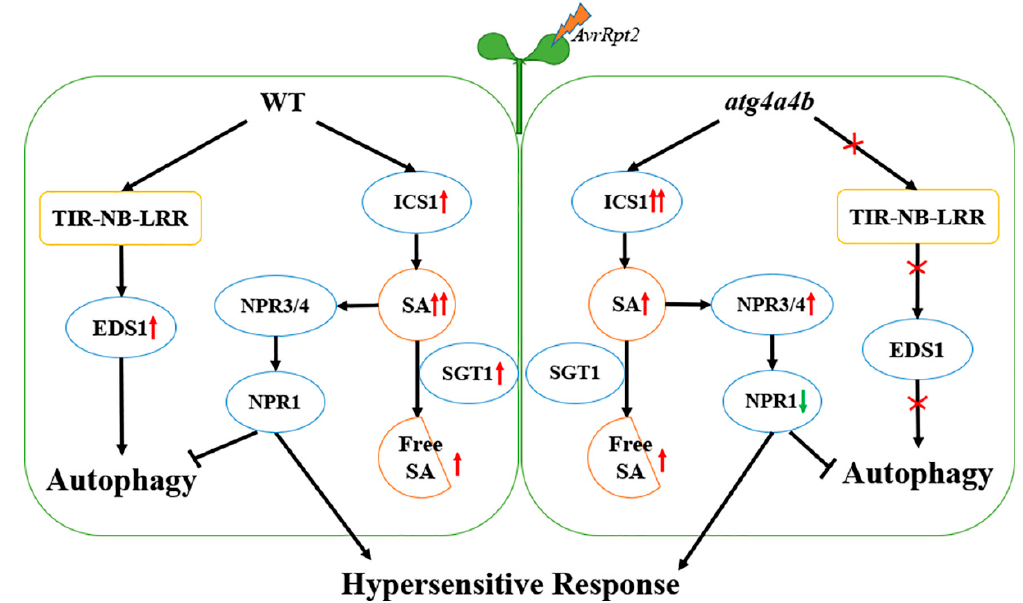
Figure 5. Working model. AvrRpt2 induced autophagy-dependent hypersensitive response via EDS1. ATG4 may suppress NPR3 synthesis via inhibiting the consumption of free SA and promote the expression of NPR1. The red arrow means up-regulated and the green arrow means down-regulated. Two arrows indicate high degree.